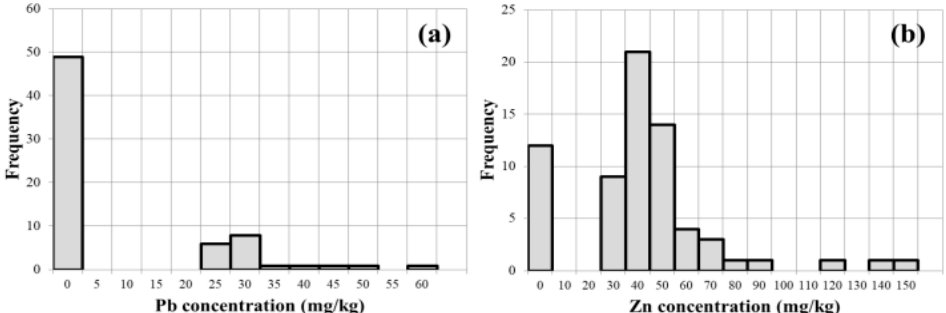
Figure 2. ( a ) Pb and ( b ) Zn concentration histograms of PXRF data.